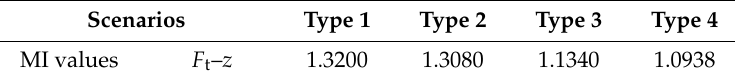
Table 4. MI values of tower model under di ff erent wind